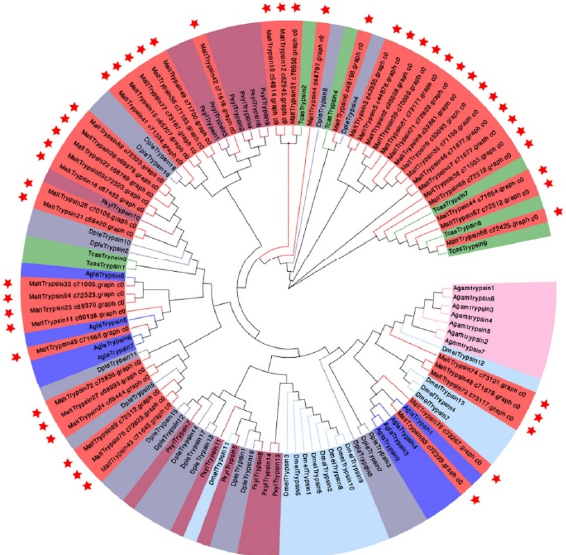
Figure 4. Phylogenetic analysis of trypsin genes in Monochamus alternatus . Phylogenetic analysis of trypsin. Included are trypsin from M. alternatus (Malt), A. glabripennis (Agla), A. gambiae (Agam), Danaus plexippus (Dple), T. castaneum (Tcas), Plutella xylostella (Pxyl), and D. melanogaster (Dmel). Trypsins from different species are indicated by different colors. The trypsin genes of M. alternatus are marked with red stars.